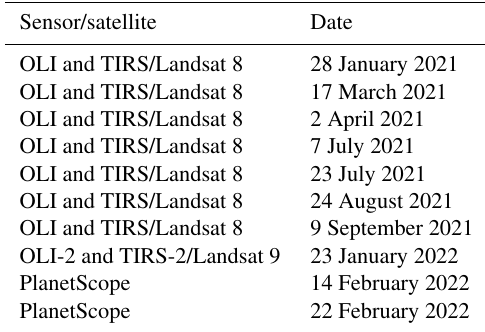
Table 2. Satellite imagery used in this study.